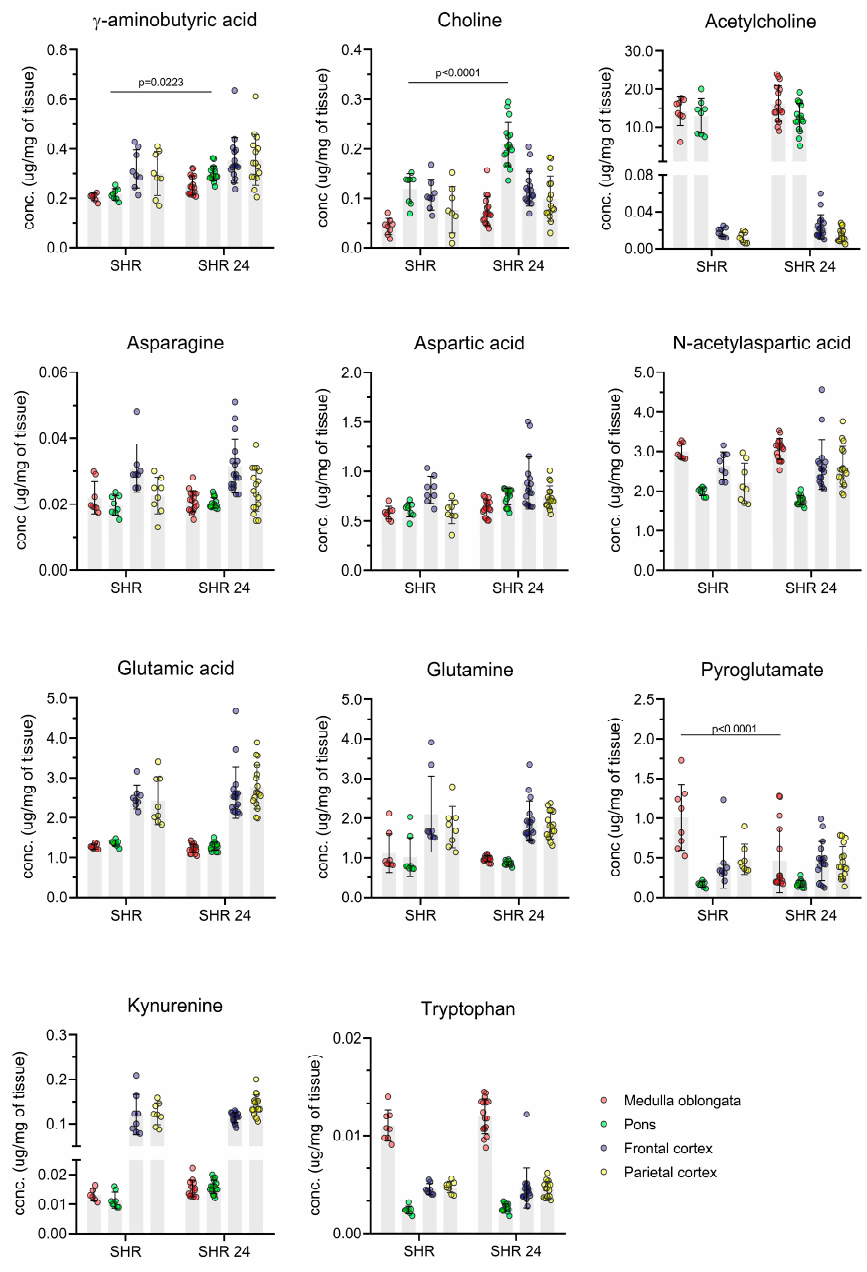
Figure 3. The changes in selected NT, tryptophan and kynurenine concentrations in brain tissue samples obtained from SHR 24 transgenic rats (SHR 24) and from control age-matched rats (SHR).